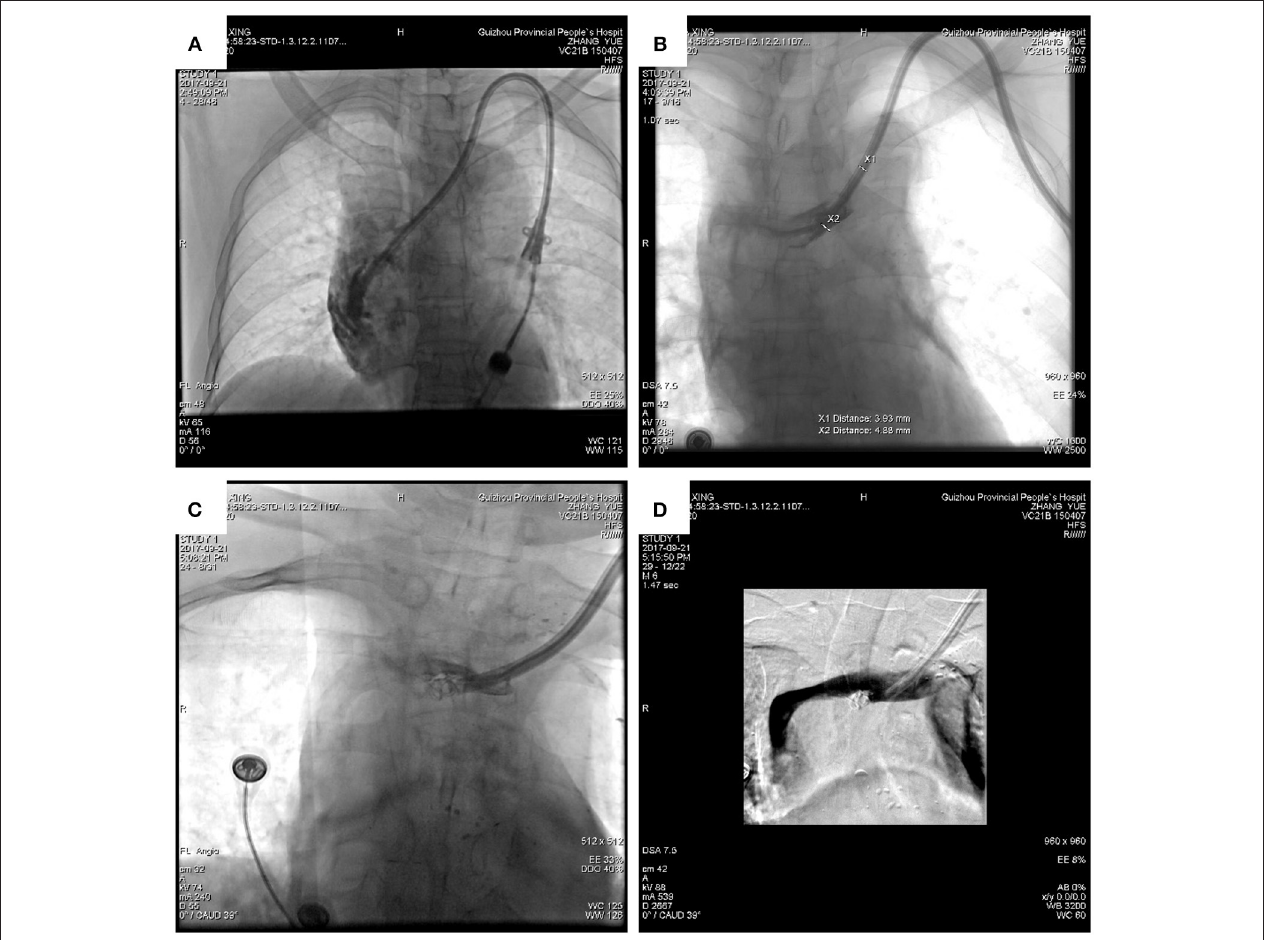
FIGURE 2 | DSA revealed that the hemodialysis catheter had penetrated the brachiocephalic vein into the mediastinum (A) . The diameter of the vascular rupture was approximately 5mm (B) . The catheter was drawn out slowly, and the vascular rupture was blocked with two embolization coils (C) . The catheter was returned to the lumen of the brachiocephalic vein, the perforation was blocked, and there was no bleeding (D)